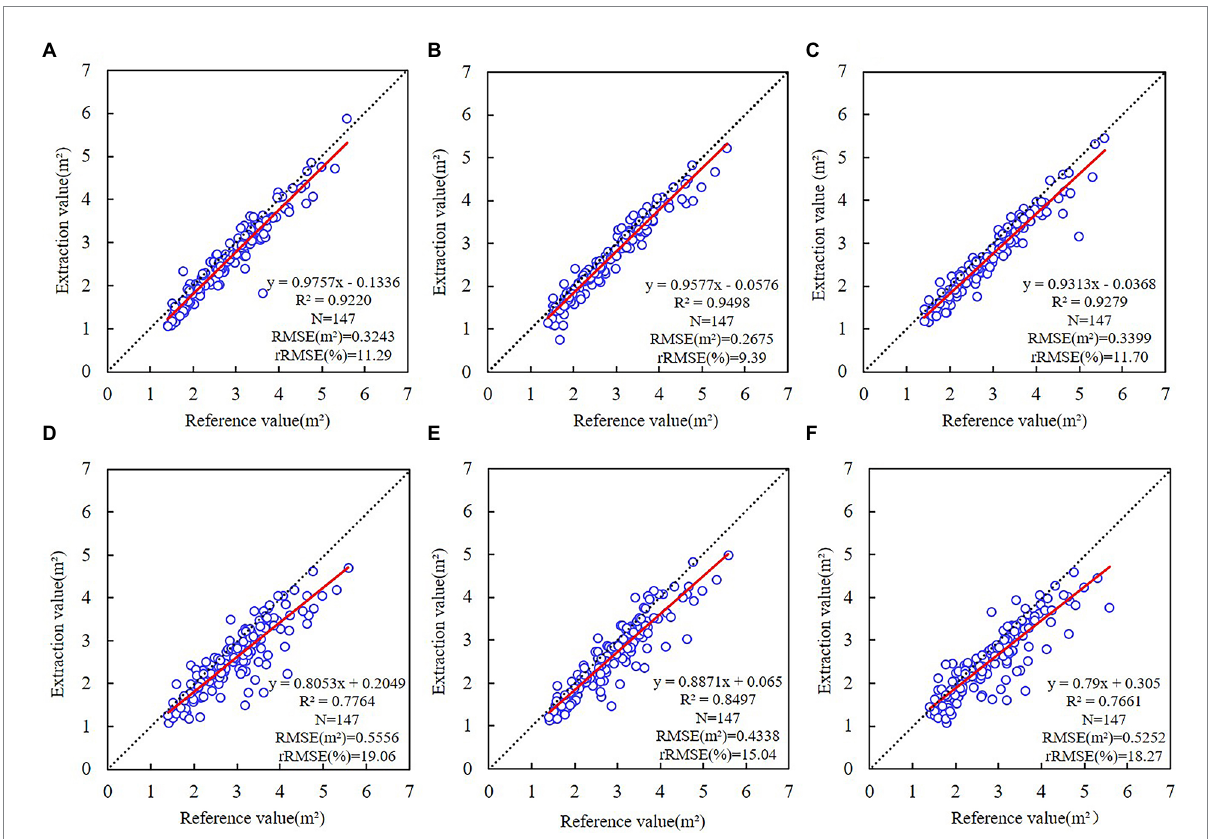
FIGURE 6 Linear regressions of crown projection area between UAV imagery and different ResU-Net models. (A) RGB; (B) RGB-CHM; (C) RGB-DSM; (D) EXG; (E) EXG-CHM; (F) EXG-DSM. The dotted line represents a 1:1 match, and the red line represents the trend of the crown projection area relationship based on the ResU-Net model and UAV